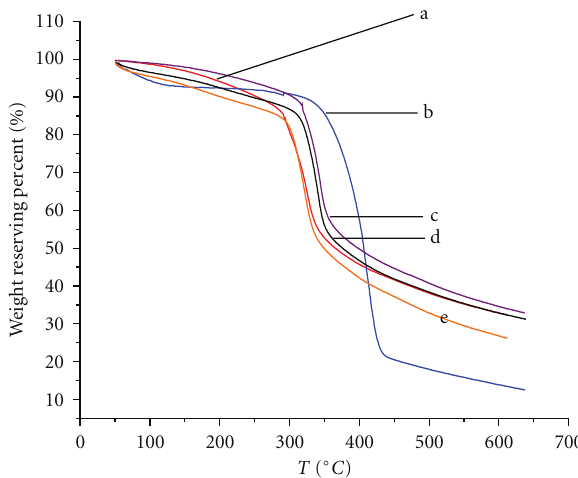
Figure 8: DTG curves for (a) CS rod, (b) CHF, (c) CHF/CS (0.25/100, wt/wt), (d) CHF/CS (0.5/100, wt/wt), and (e) CHF/CS (1/100, wt/wt), in the 50–600 ◦ C temperature range under N 2 atmosphere.